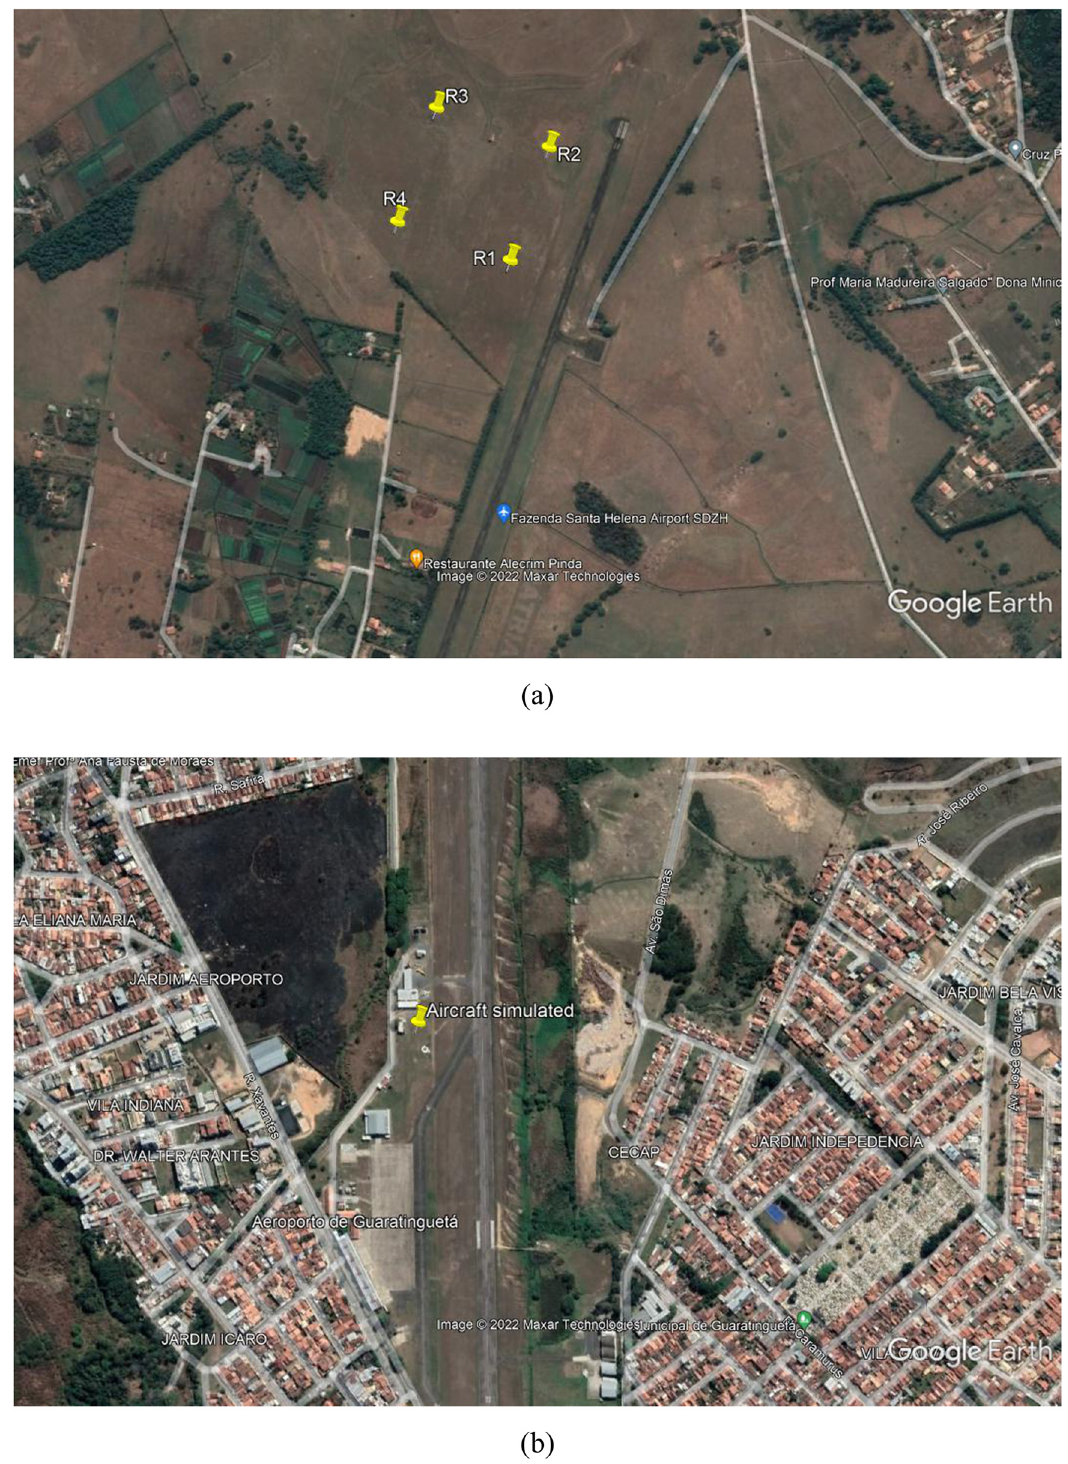
Figure 5: ( a ) Location of the reference GNSS stations used in the experiment; ( b ) location of aircraft simulated in the